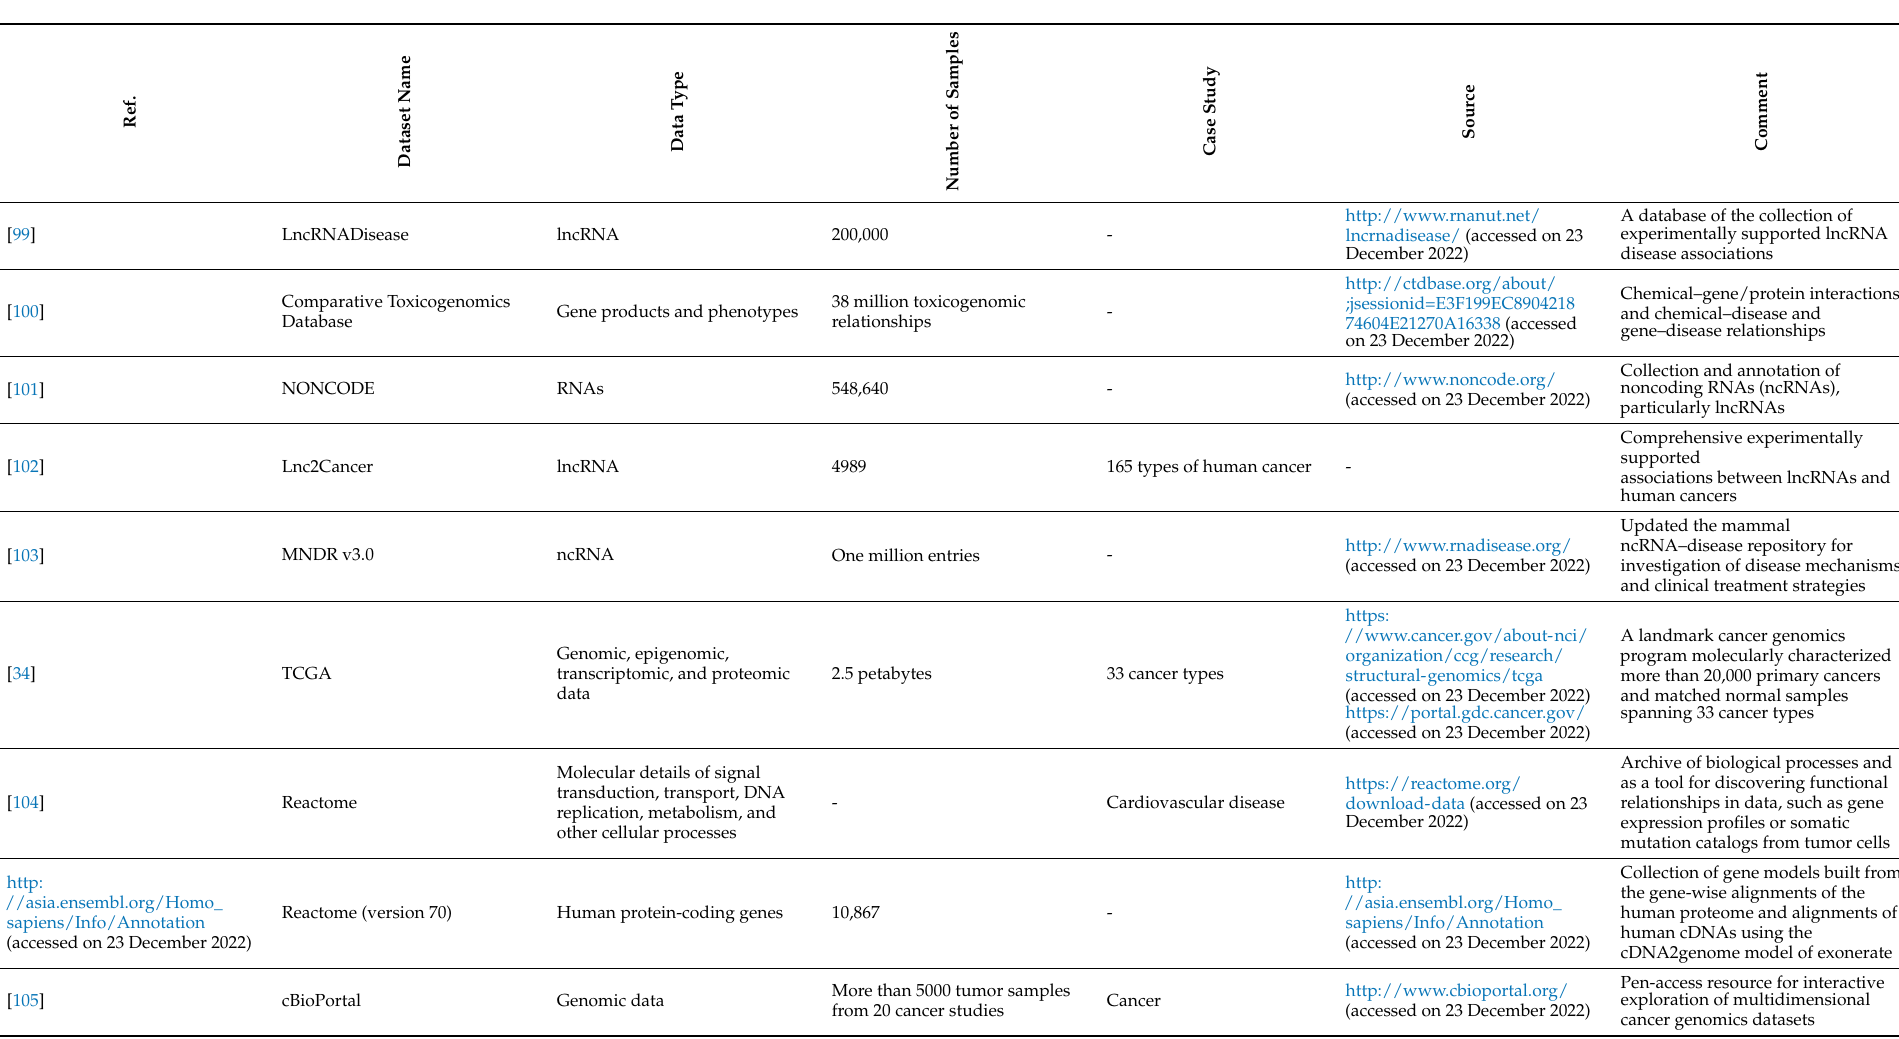
Table 7. Available omics